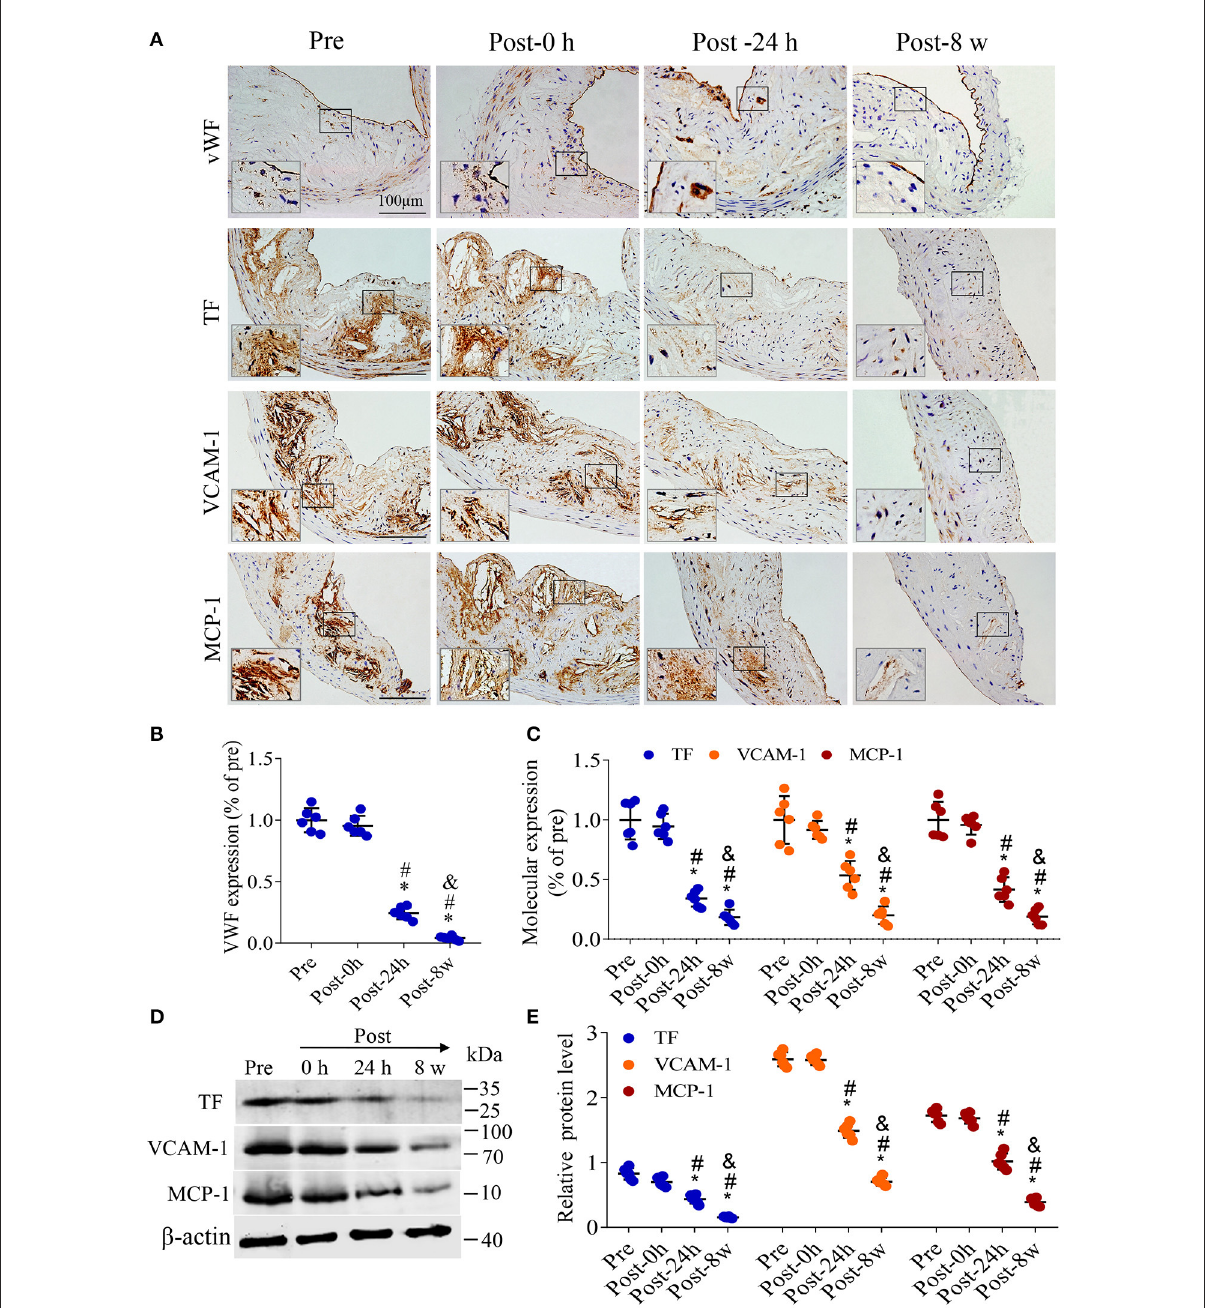
FIGURE6 DUMB R treatment reduces the expression of platelet adhesion promoters, thrombogenic factors, adhesion molecules and chemokines. (A) Representative images of Immunohistochemistry for von Willebrand factor (vWF), tissue factor (TF), vascular cell adhesion molecule-1 (VCAM-1) and monocyte chemotactic protein (MCP-1) before treatment and at 0h, 24h and 8 weeks after treatment with DUMB R at an MI of 1.5. Quantification of (B) vWF, (C) TF, VCAM-1 and MCP-1 at different time points is shown. (D) Representative immunoprecipitation images of TF, VCAM-1 and MCP-1 in plaques before treatment and at 0h, 24h, and 8w after treatment with DUMB R at an MI of 1.5. (E) Quantification of the immunoblot strip. n = 6 per group. * P < 0.05 vs. pretreatment. # P < 0.05 vs. Post-0h, & P < 0.05 vs. Post-24h, n = 6 per group.